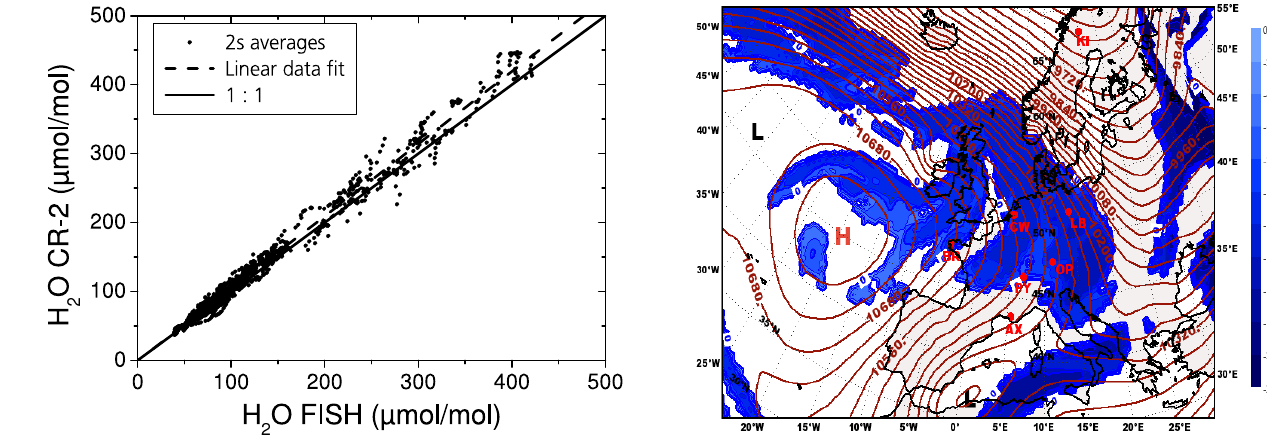
Fig. 2. 36 hour forecast of the Schmidt-Appleman criterion at 250 hPa, valid on 19 November 12 UTC. Shown is the difference be- tween the ambient temperature ( K ) as forecasted by the ECMWF and the threshold temperature for contrail formation as computed from the Schmidt-Appleman theory. Values are only plotted in re- gions where the relative humidity is larger than 80%, that is con- trails that form in such a region have a high probability to be persis- tent. Red contours show the geopotential height ( m )